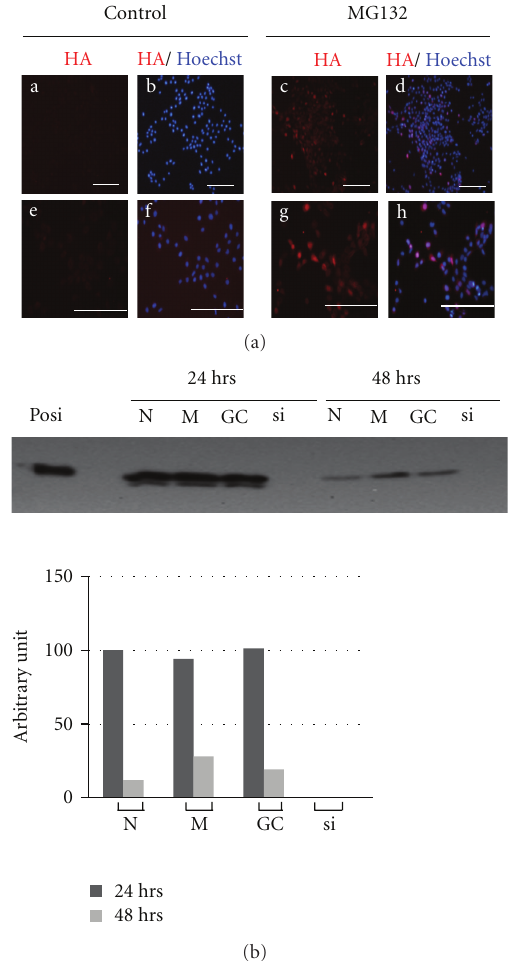
Figure 3: Specificity of SP6 induction by MG132 treatment. (a) Subcellular localization of SP6 in C9 cells treated with MG132. SP6 localization was analysed by immunofluorescence signals. Red colour indicates SP6 detected by anti-HA antibody, blue colour shows nuclei stained with Hoechst 33342. (a–d): low magnification; (e–h): high magnification. Scale bar indicates 200 µ m. (b) Knock- down of SP6 in MG132-treated C9 cells by siRNA. Posi: positive control; N: no treatment; M: Lipofectamine RNAiMAX only; GC: negative control siRNA; si: siRNA against Sp6 . Upper panel: SP6 expression was detected by WB. Lower panel: relative SP6 levels estimated by densitometric analysis of WB